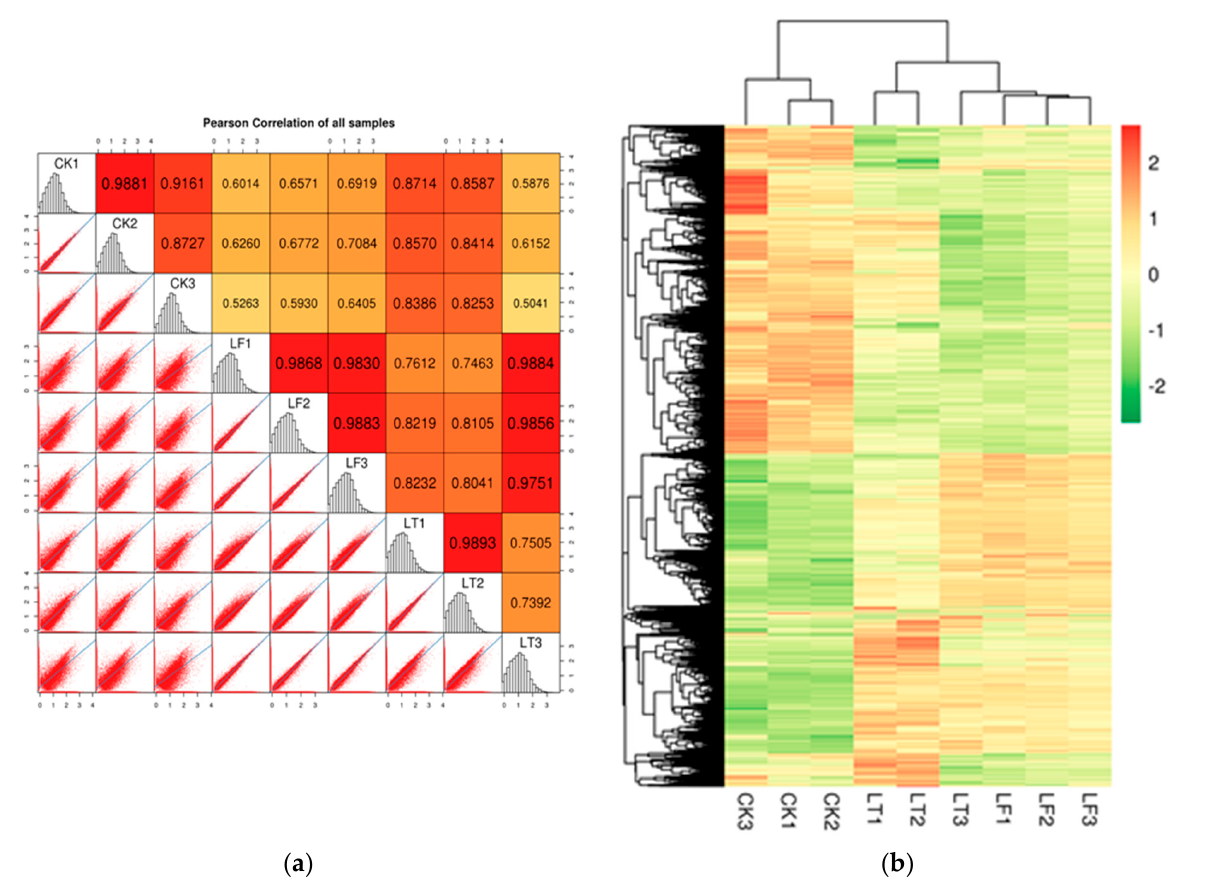
Figure 2. ( a ) Repeatability test between each two samples. Pearson coefficient closer to 1 indicates that the correlation between the two repeated samples is stronger. ( b ) Results of hierarchical cluster analysis of differentially expressed genes. Different columns represent different samples, and different rows represent different genes.